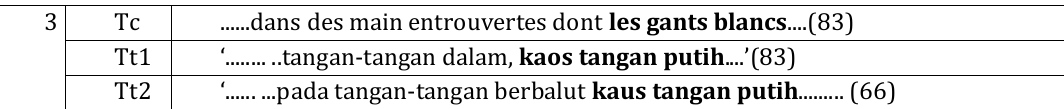
Tableu 3 La conformité des règles